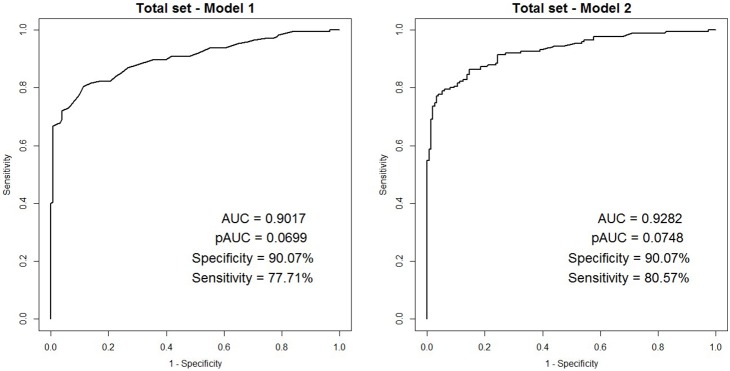
ROC curves for the two models for all patients (total set).